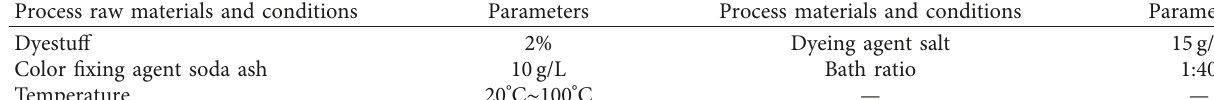
Figure 5: Process flow. Table 3: Indicators of dyes in dyeing process.